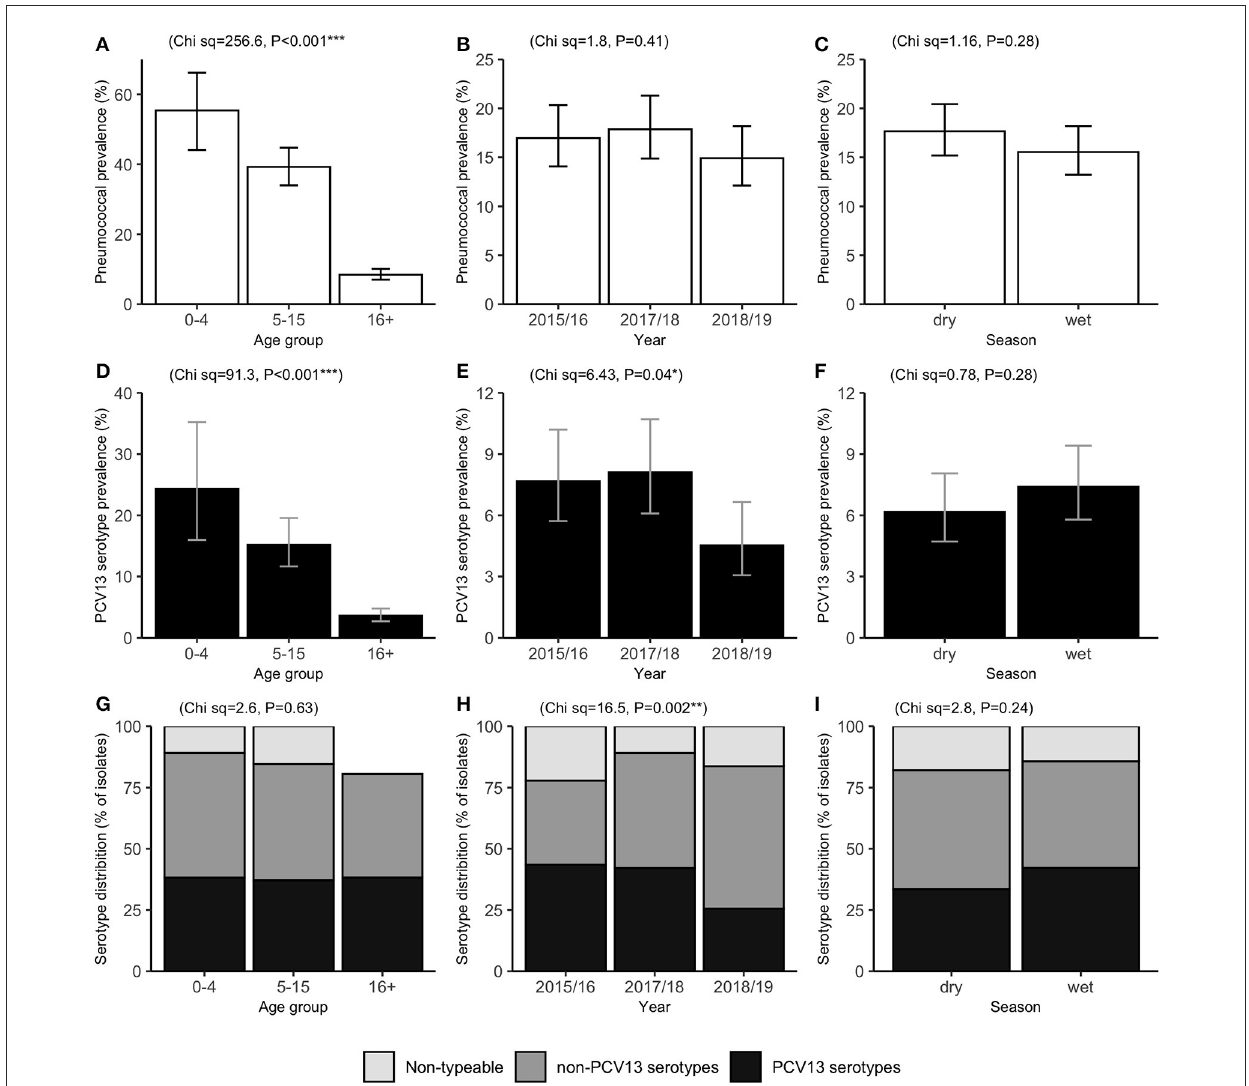
FIGURE1 Prevalence of pneumococcal carriage (A–C) and PCV13 serotype carriage (D–F), and the percentage of pneumococcal isolates by serotype category (G–I) . Results are shown among influenza-like illness cases ( n = 1,621), by age group (left), surveillance period (middle), and season (right). PCV13: 13-valent pneumococcal conjugate vaccine. Error bars represent exact 95% confidence intervals. Chi-squared (Ch sq) statistics and P -values for association with x-axis levels are shown at the top of each